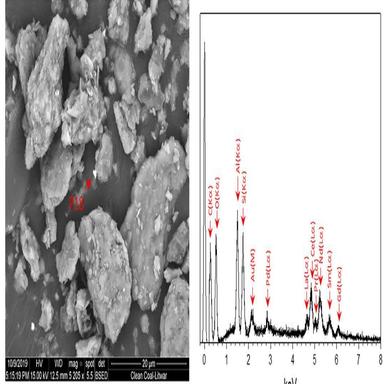
A rare earth carbonate particle found in SP25-F1 (Au and Pd were introduced during the coating process prior to the SEM-EDX analysis).